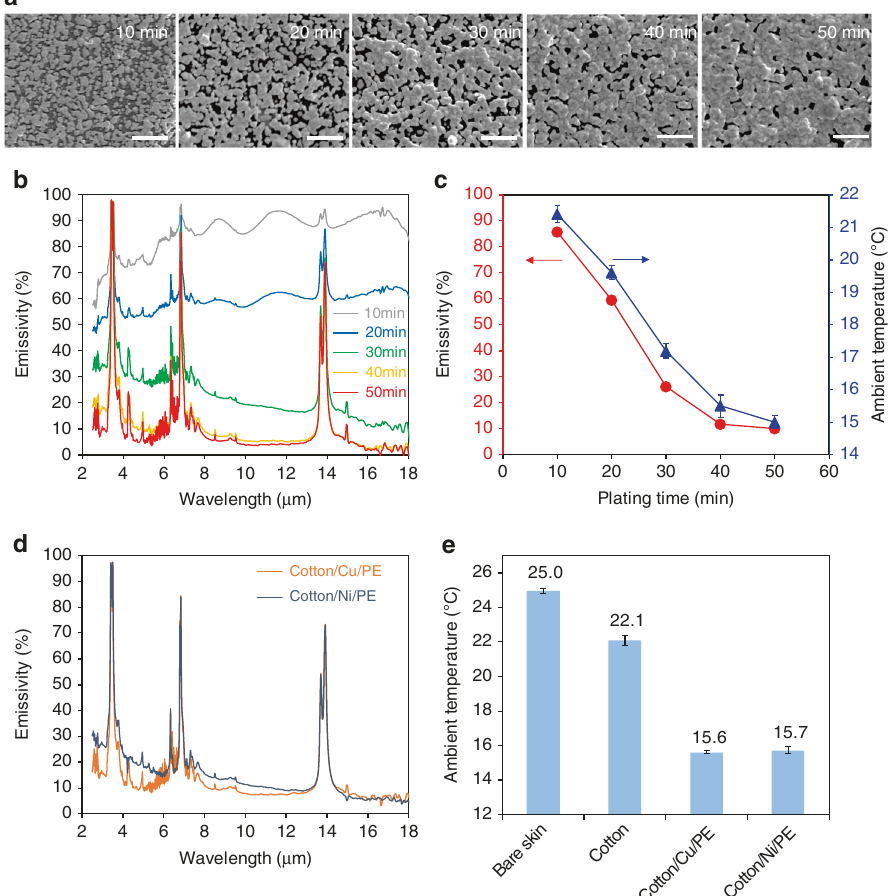
Fig. 5 Tunability of IR radiation property and versatile choices of low-cost metals. a SEM images of the electrolessly plated Ag fi lm with varying plating time from 10 to 50 min. Scale bar , 1 µ m. b IR emittance spectra of the cotton/Ag/PE textiles with different Ag plating time. c Plots of the average IR emissivity (normalized over human body radiation) and the measured set-point of ambient temperature vs. the Ag plating time. d Measured IR emittance of the cotton/Cu/PE and cotton/Ni/PE textile samples. e Comparison of the set-points for bare skin, cotton, cotton/Cu/PE and cotton/Ni/PE. All error bars represent the standard